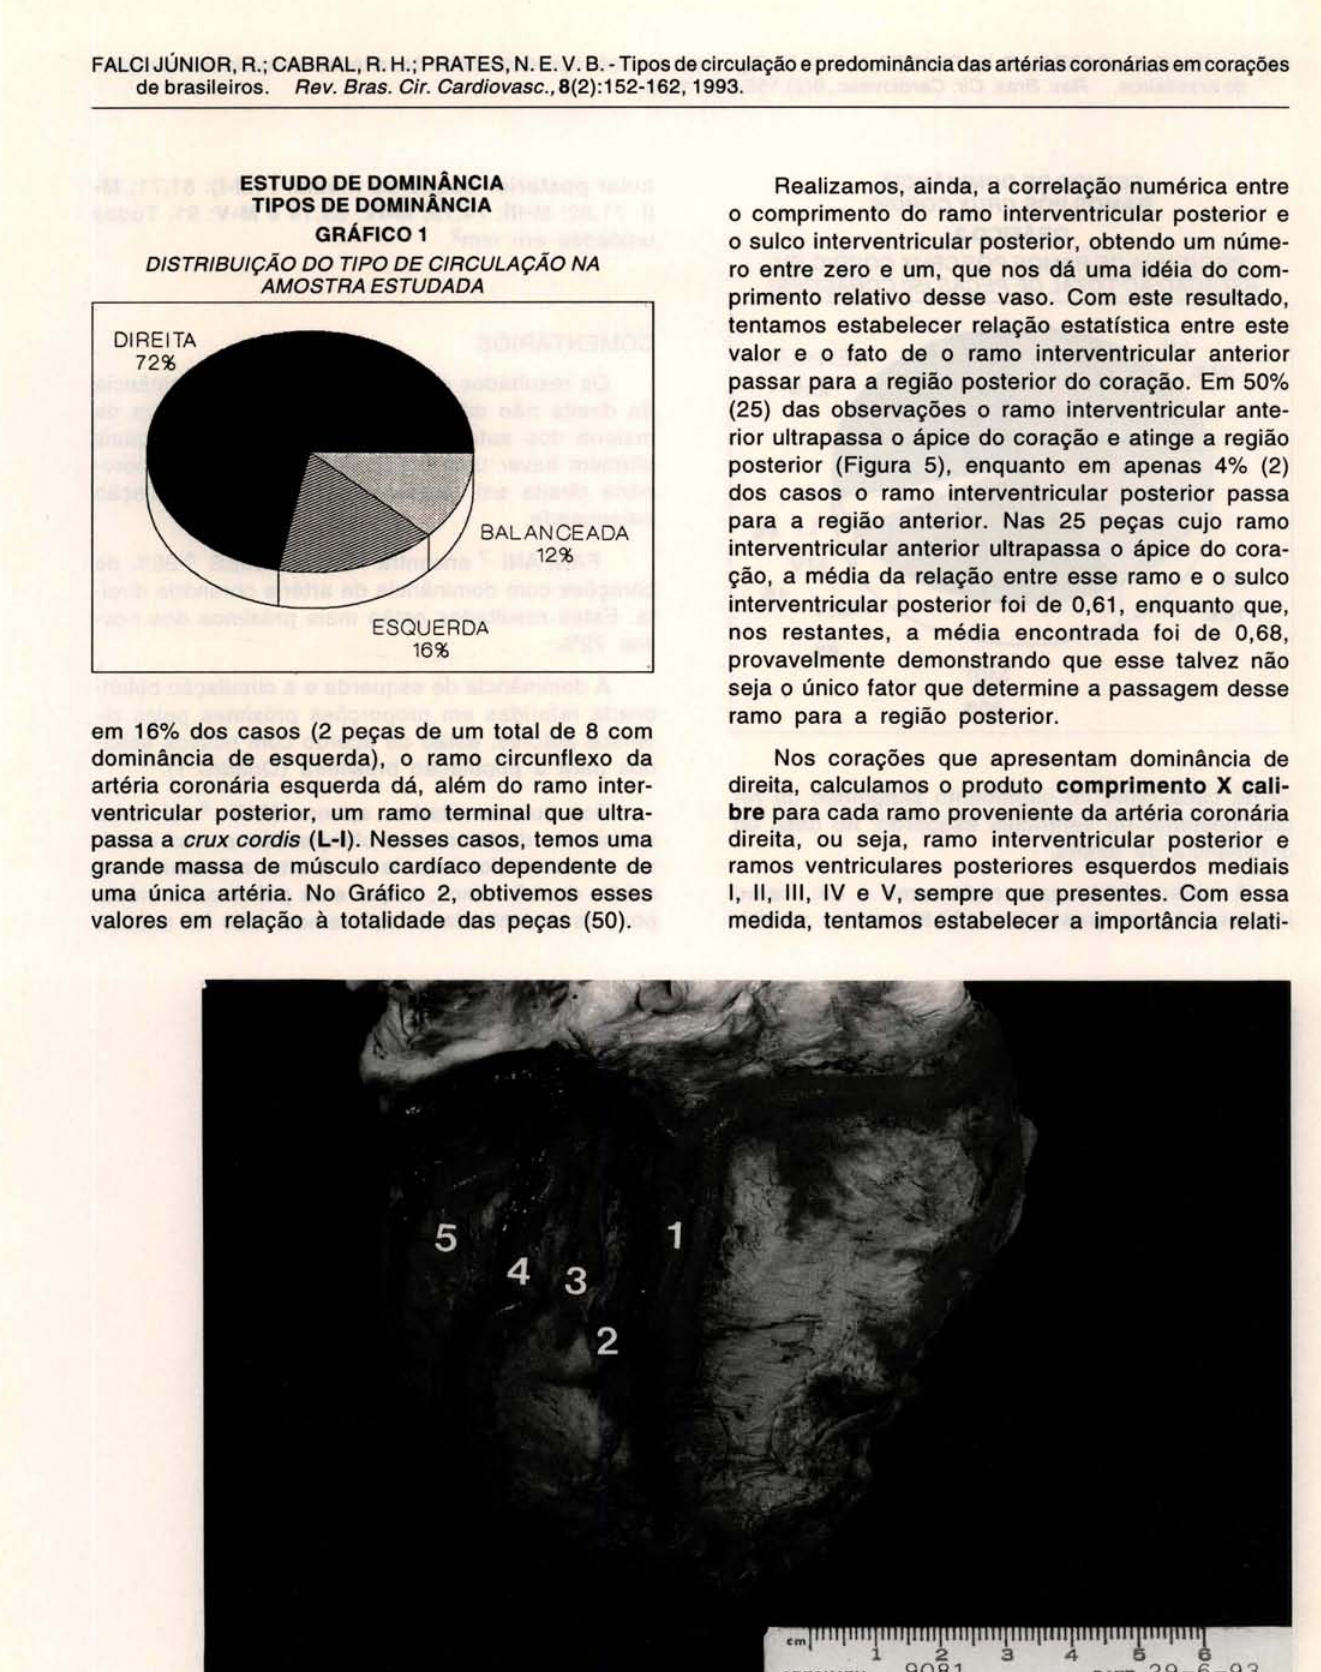
Fig. 4 - Fotografia de coração apresentando circulação de dominância de direita. Notar os cinco ramos que ultrapassam a crux cordis: M-I (1), M· II (2), M-III (3), M·IV (4) e M-V